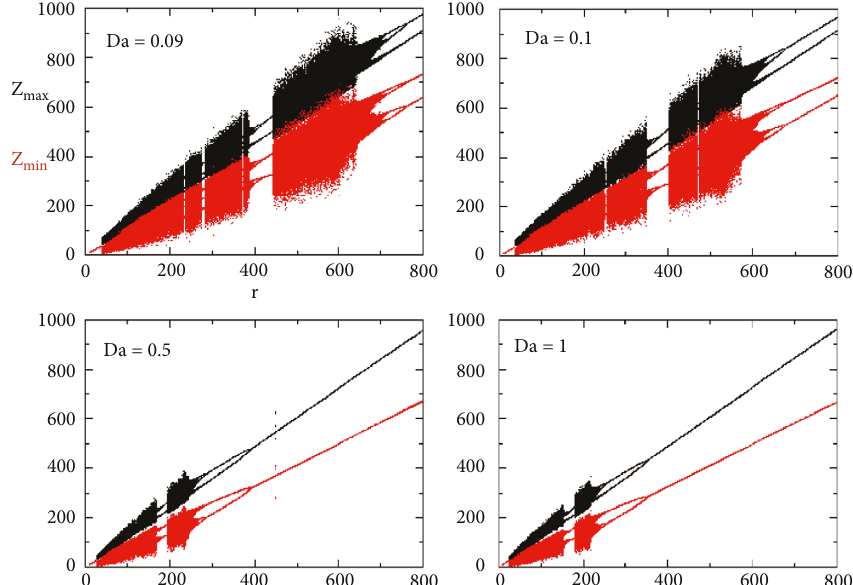
Figure 8: Diagrams of bifurcations of Z as a function of r showing the effect of the Darcy number Da on the chaos of the system when s � 0 with the parameter values of Figure 5.